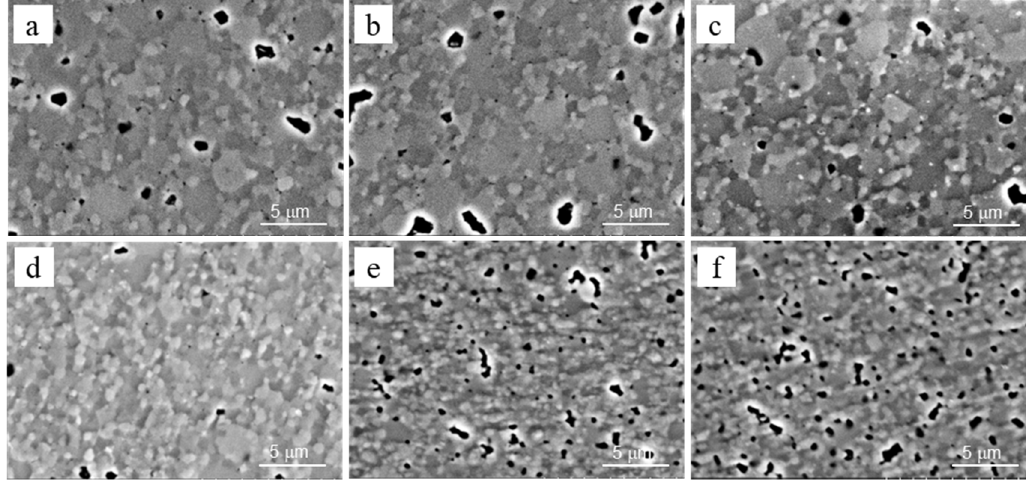
Figure 3. SEM-SE images of microstructures for the studied materials containing ( a ) 3%, ( b ) 4%, ( c ) 5%, ( d ) 6%, ( e ) 7%, and ( f ) 8% Y 2 O 3 .